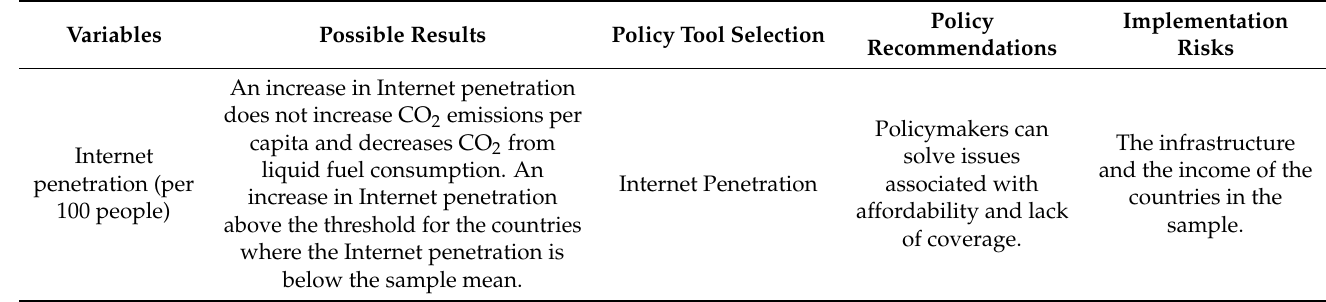
Table A2. The Policy Tool Selection and Implementation